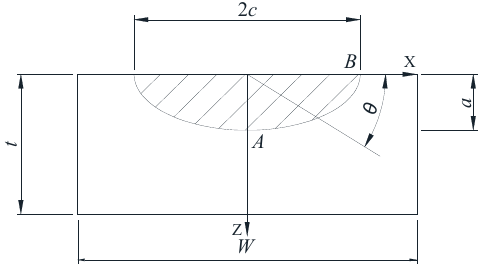
Figure 1. Semi-elliptical surface crack in a rectangular plate.